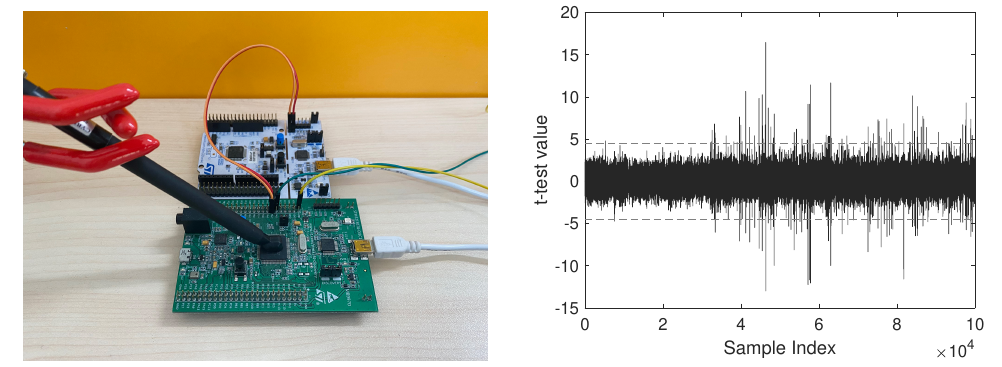
Figure 4: Our SCA equipment (left) and TVLA results between re-encryption of m 0 and m 1